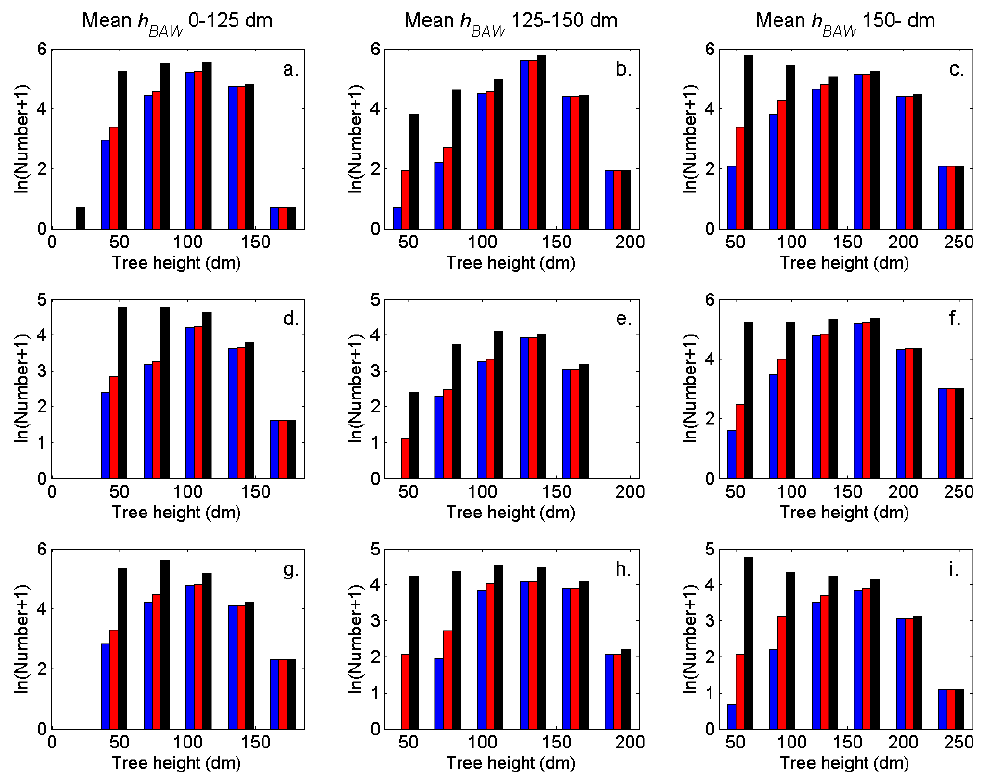
Figure 9. The tree height distributions (log scale) in the strata defined in Table 1 for the segments (blue), the trees linked to clusters (red), and the field-measured trees